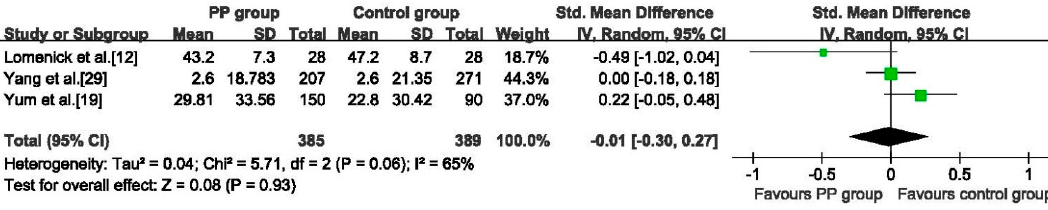
Figure 6. Forest plot for concentration of MEHP between PP group and Control group.